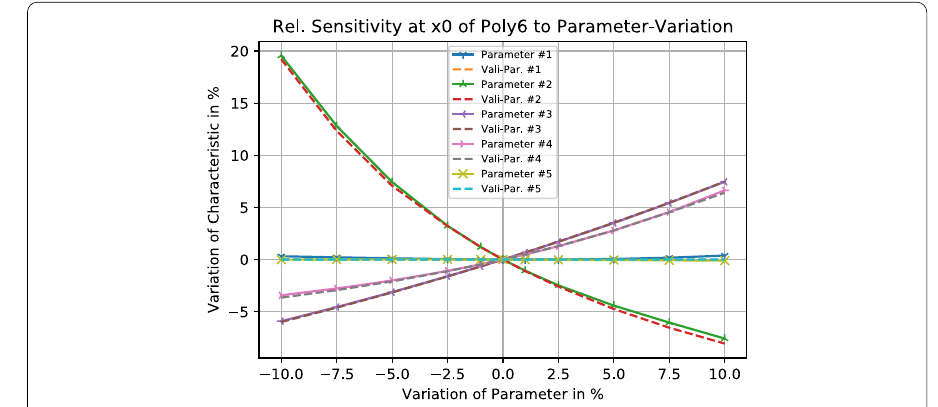
Fig. 29 Sensitivity ridge-regression of Poly-degree 6